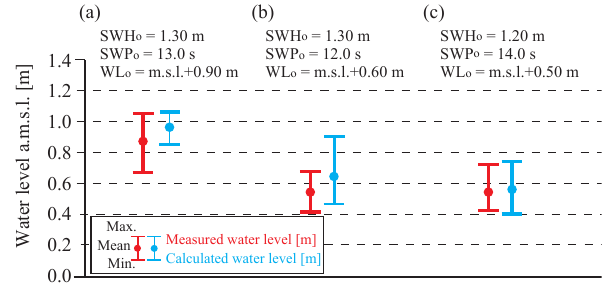
Figure 2. Comparison of in situ measurements and calculated re- sults of water levels on the reef flat (400m from the shore) at the study site. (a) Test 1: the assumed SWH o and SWP o values were 1.30m and 13.0s, respectively. The assumed WL o value was + 0.90ma.m.s.l. (b) Test 2: the assumed SWH o and SWP o values were 1.30m and 12.0s, respectively. The assumed WL o value was + 0.60ma.m.s.l. (c) Test 3: the assumed SWH o and SWP o values were 1.20m and 13.0s, respectively. The assumed WL o value was + 0.50ma.m.s.l.